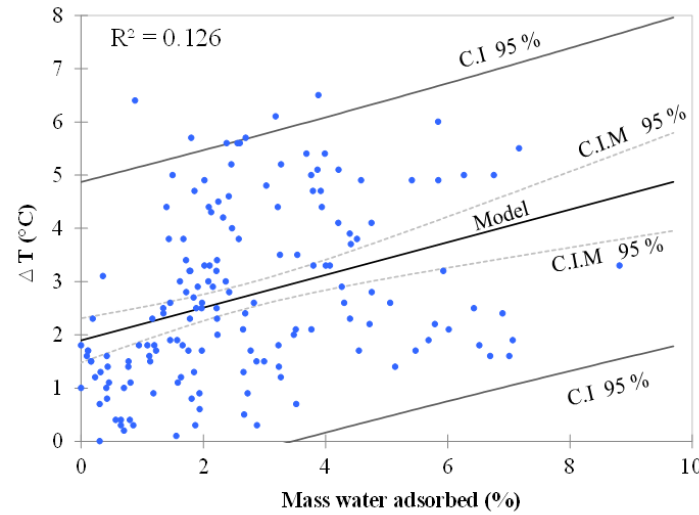
Figure 4. Regression line of temperature (°C) vs. water adsorption (%) with two confidence intervals (C.I) at 95%. The confidence interval on mean (C.I.M) of the prediction for a given value of T is the one closer to the line.